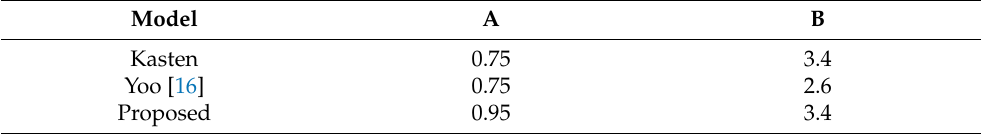
Table 1. The coefficients to estimate global horizontal irradiance (GHI) for each model.